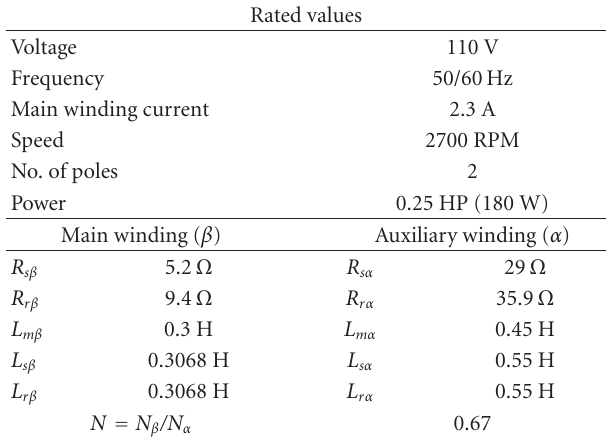
Figure 4: SPIM test bench. Table 1: SPIM data. Table 2: Electrical characteristics of the IGBT power